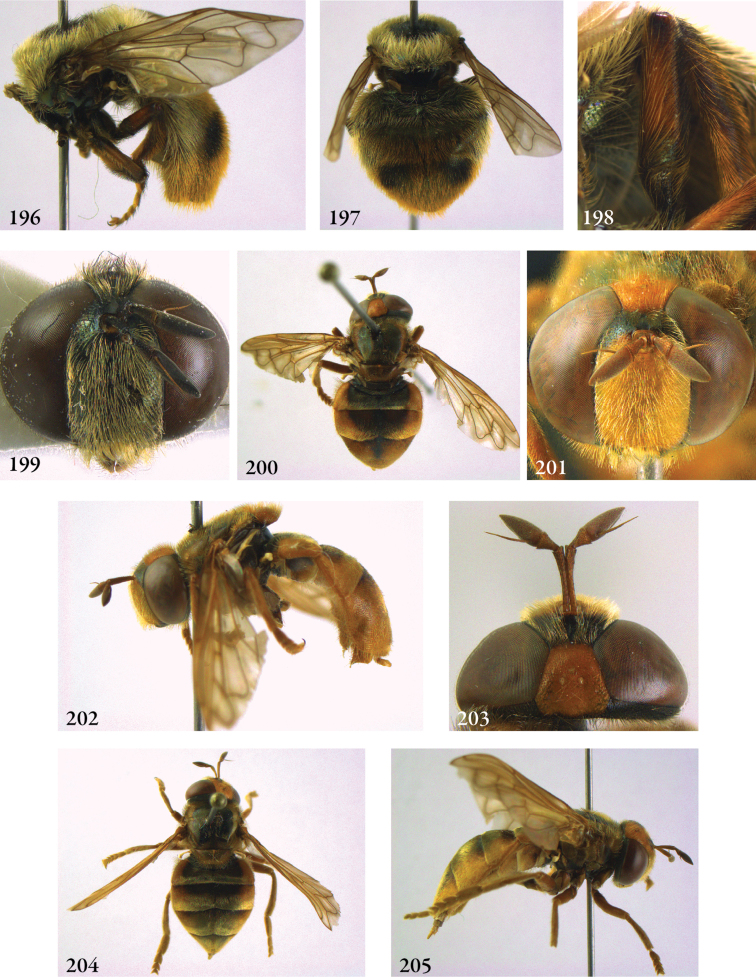
196–199
Microdon (Microdon) hauseri male (holotype): 196 habitus lateral 197 abdomen dorsal 198 hind femur, frontal 199 head frontal 200–203
Microdon (Microdon) mandarinus male (holotype): 200 habitus dorsal 201 head frontal 202 habitus lateral 203 head dorsal. 204–205
Microdon (Microdon) mandarinus female (paratype): 204 habitus dorsal 205 habitus lateral.